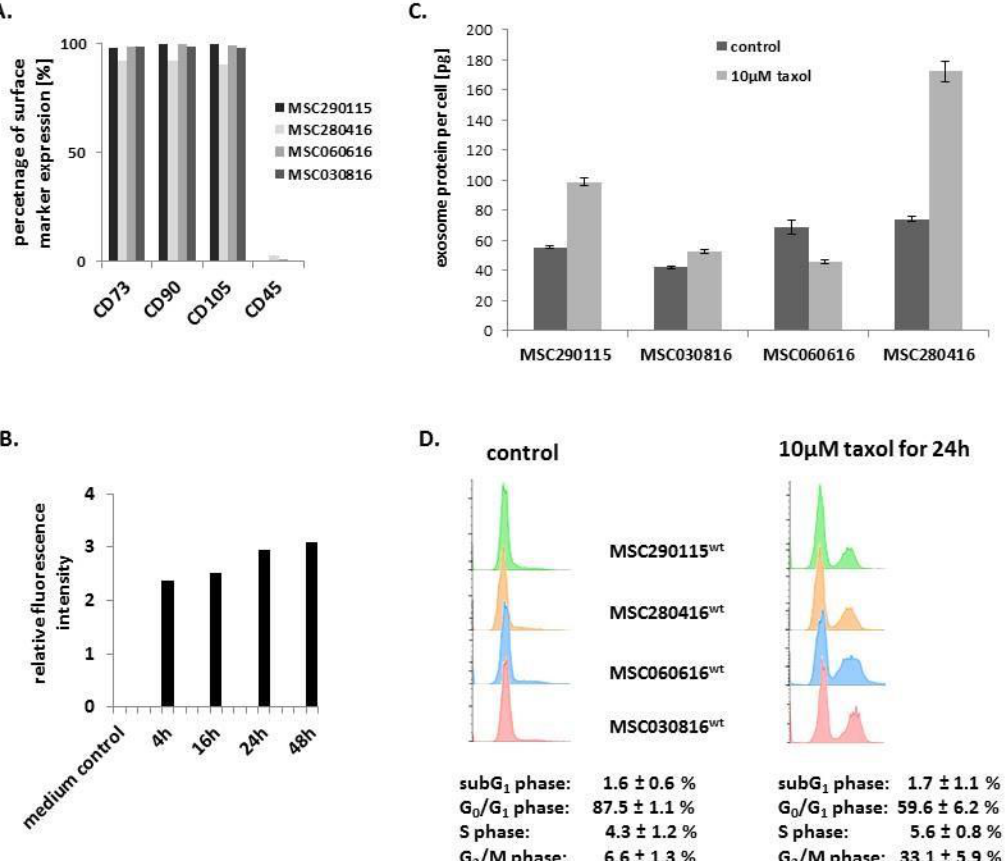
Figure 1. ( A ) Characterization of four di ff erent mesenchymal stroma / stem-like cells (MSC) populations (MSC280416 P2; MSC290115 P3; MSC030816 P4; MSC060616 P6) was performed by flow